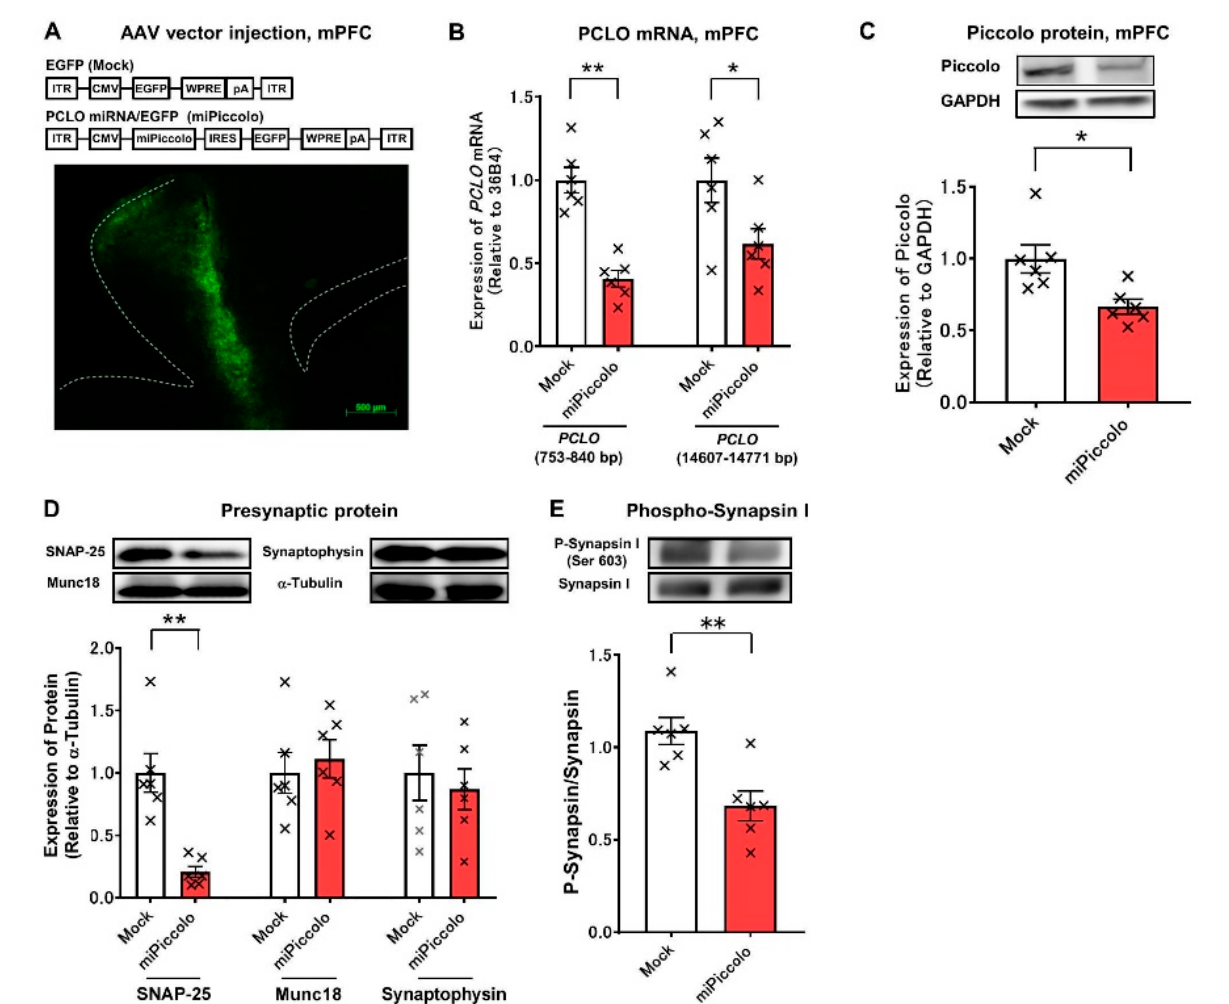
Figure 1. Generation of miPiccolo mice. ( A ) Upper panel, Sequence of AAV-EGFP or AAV- Pclo miRNA/EGFP vectors. The AAV vector was constructed using the cytomegalovirus immediate-early promoter (CMV) to drive EGFP or Pclo miRNA/EGFP. ITR: inverted terminal repeats, IRES: internal ribosomal entry site, WRPE: woodchuck hepatitis virus post- transcriptional regulatory element, pA: polyadenylation signal sequences. Lower panel, a fluorescent microscopic image of GFP in the mPFC of miPiccolo mouse (sagittal section). ( B ) The expression of Pclo mRNA was measured by quantitative real-time RT-PCR and presented as relative to the expression of the housekeeping gene 36B4 (n = 6). * p < 0.05, ** p < 0.01 vs. Mock (Student’s t -test). ( C ) The expression of Piccolo was measured by Western blotting and presented as relative to the expression of GAPDH (n = 6). * p < 0.05 vs. Mock (Student’s t -test). ( D ) The expression of presynaptic proteins in the mPFC. The bar graphs show the quantification of the expression of each protein compared with the expression of α -tubulin (n = 6). ** p < 0.01 vs. Mock (Student- t test). ( E ) The phosphorylation of Synapsin I in the mPFC was measured by Western blotting and presented as relative to the expression of Synapsin I (n = 6). ** p < 0.01 vs. Mock (Student’s t -test).